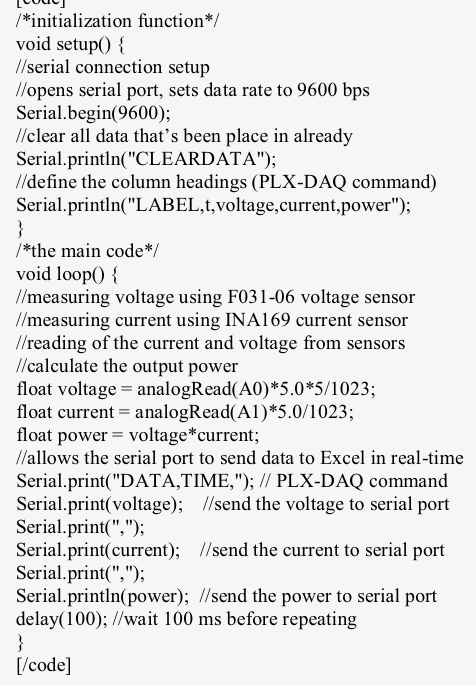
72 °C and G 1100 W/m 2 = =